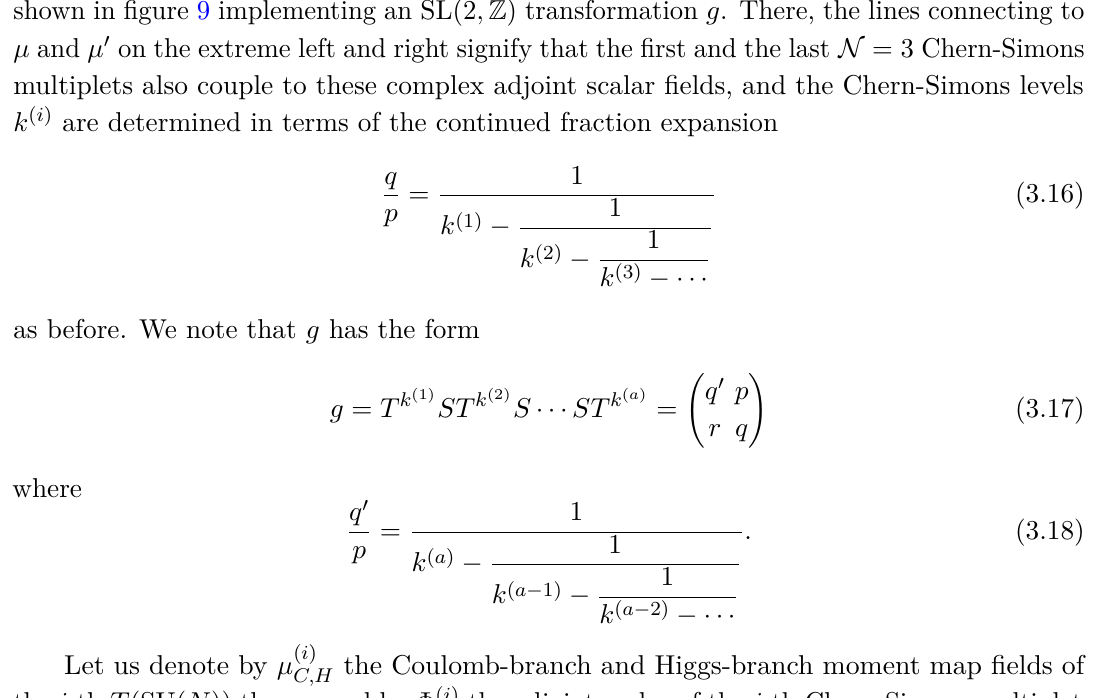
when 1 /k + 1 /k + 1 /k = 0 . This is because, as we saw in the subsection above, they come 1 2 3 from Seifert manifolds of type (0; 1 /k ) . This analysis can be easily generalized , 1 /k , 1 /k 1 2 3 to the T theory whose SU( N ) m symmetry is gauged with Chern-Simons levels k N,m,g